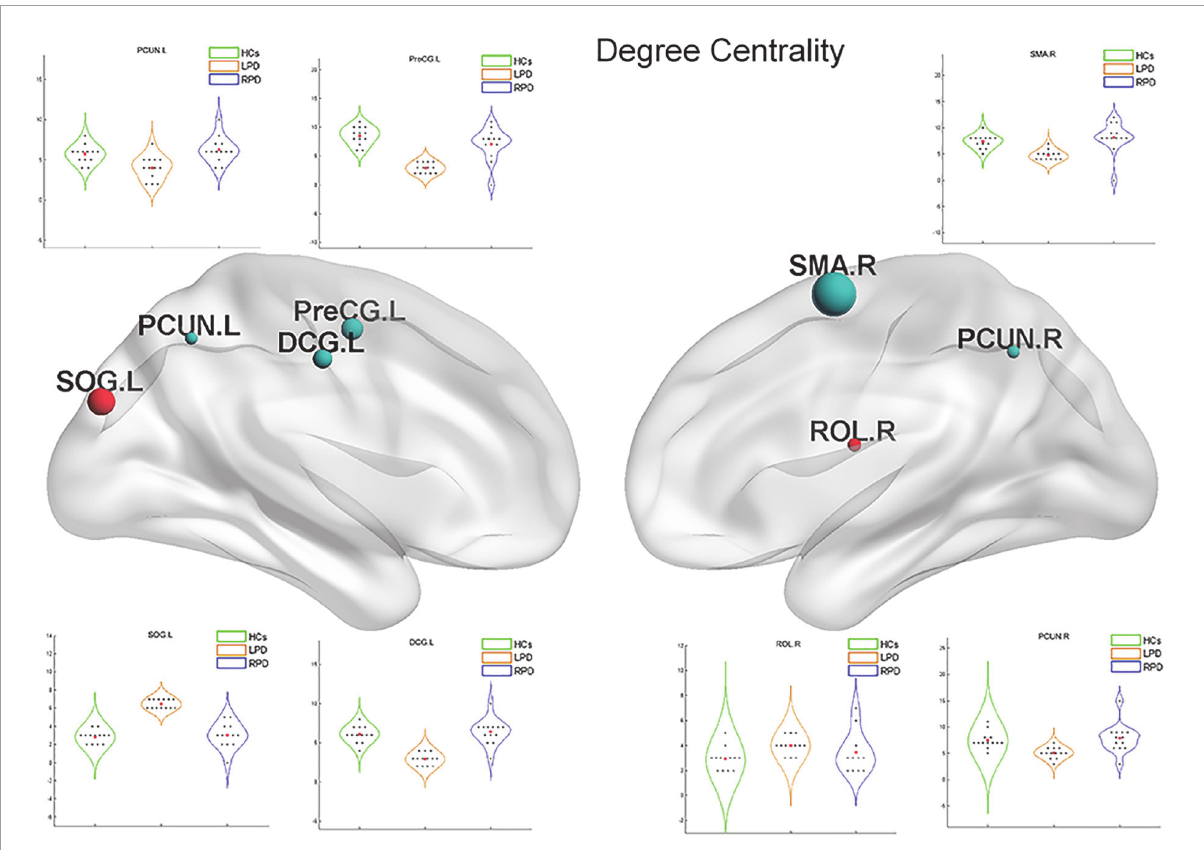
FIGURE3 Left-onset PD (LPD) patients showed decreased degree centrality (DC) in the left median cingulate and paracingulate gyri, right supplementary motor area, left precentral gyrus, right Rolandic operculum, and bilateral precuneus as well as increased DC in the left superior occipital